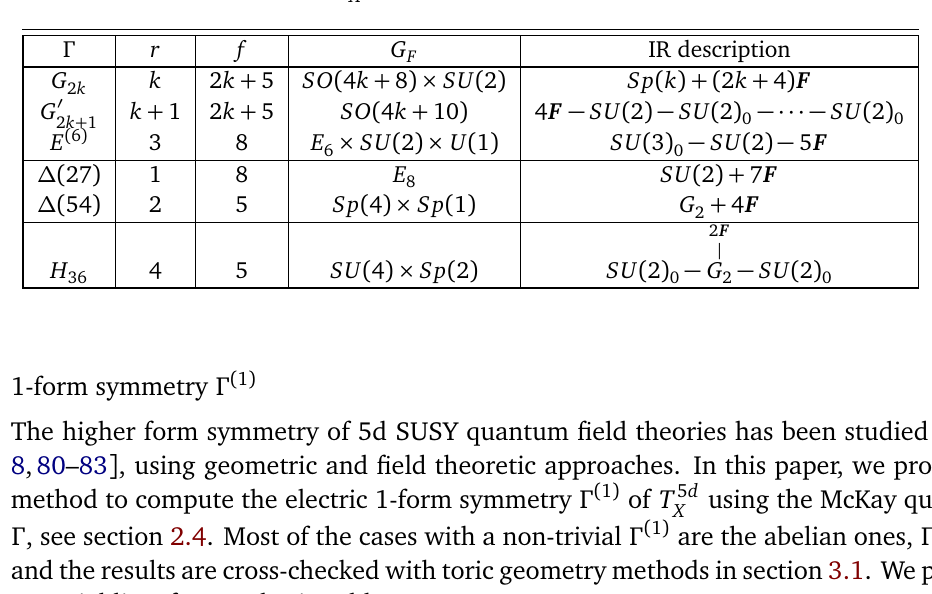
Table 3: A number of T 5 d